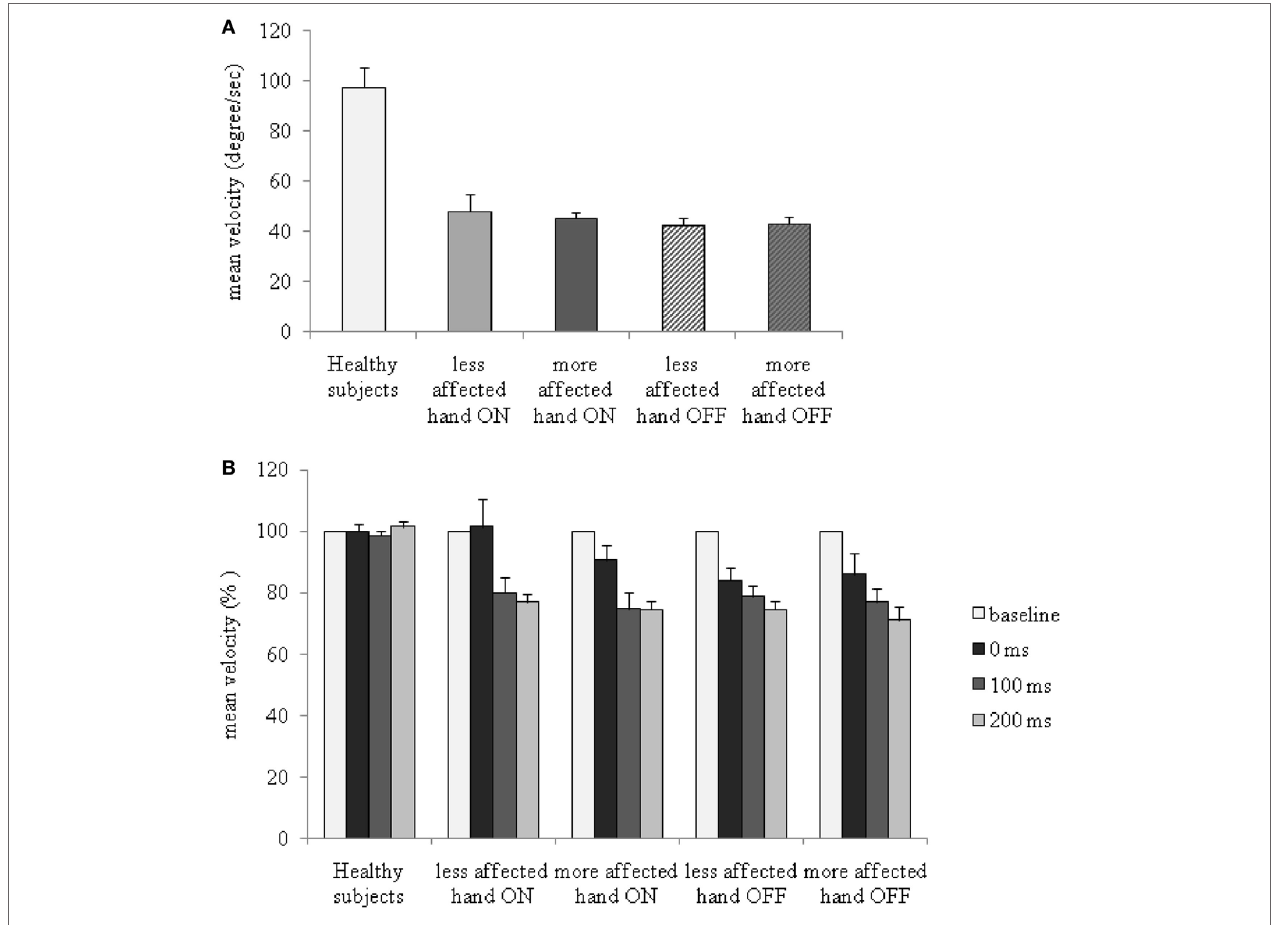
FigUre 2 | Changes in mean velocity of index finger abductions without somatosensory temporal discrimination threshold (STDT) and during STDT testing at different intervals from movement onset in patients with Parkinson’s disease, ON and OFF therapy, and in healthy subjects. (a) Mean velocity (absolute values) of index finger abductions without STDT testing. (b) Y axis: percentage changes in mean